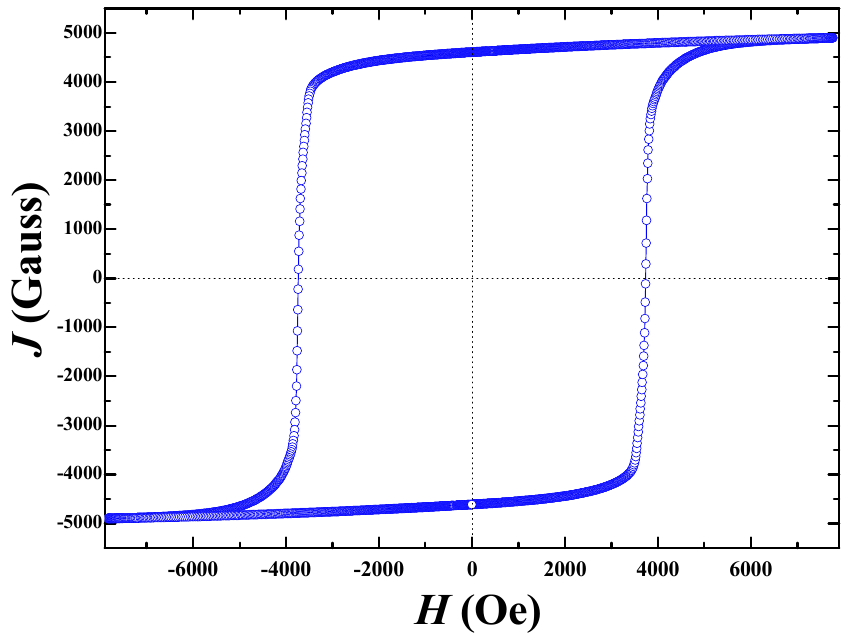
Figure 11. The B-H hysteresis curve of the La 0.3 Sr 0.7 Fe 11.4 O 19 sintered magnet with additive CaCO 3 = 0.7 wt%, SiO 2 = 0.25 wt% and Co 3 O 4 = 1.7 wt% added after calcination.